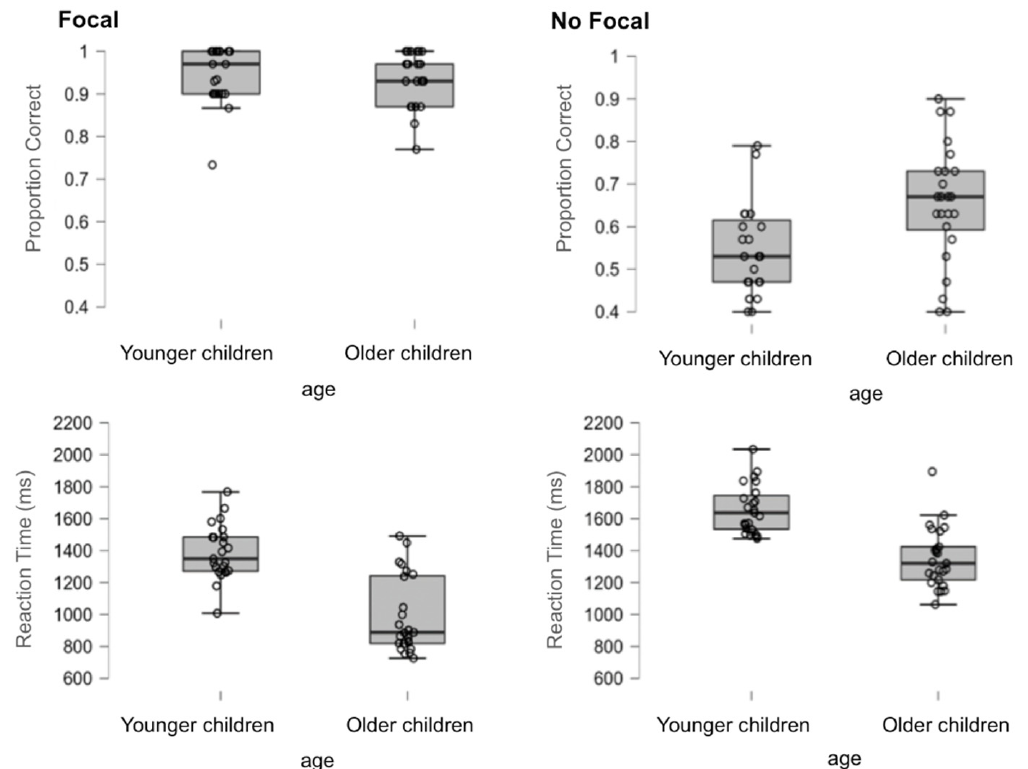
Figure 3. Box plots of correct PM responses ( top panels) and reaction times (in ms, bottom panels) for each group in focal and non-focal conditions.